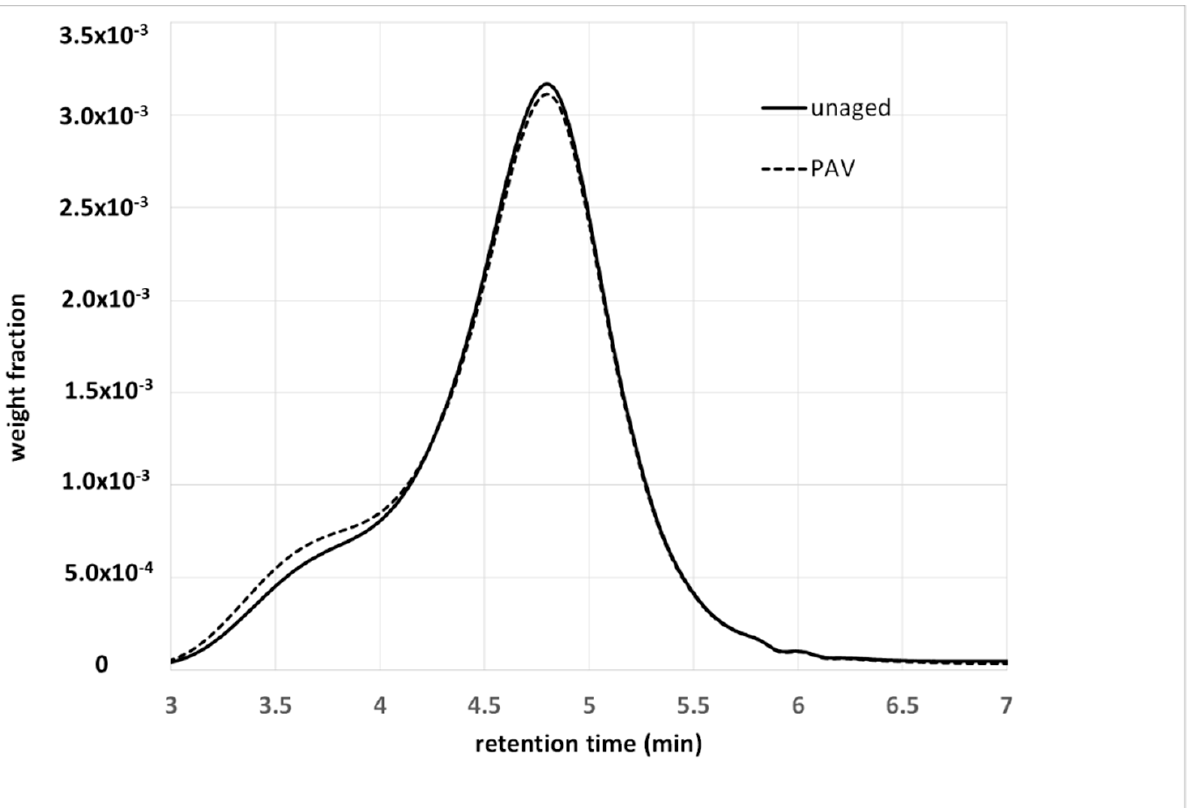
Figure 7. BMWD for a 35/50 Pen-grade base bitumen before and after PAV. All details are given in [33]. 4.2. Additives or Modifiers Many types of additives may be used to improve or restore the physical properties of bituminous binders, and, again, the SMWD and BMWD provide different information. Let us consider the case of rejuvenators, for example, which are vegetable oil added to an aged binder. Figure 8 shows the GPC spectra of a PAV-aged 50/70 penetration-grade binder, before and after the addition of a rejuvenating vegetable oil, as well as that of the oil.